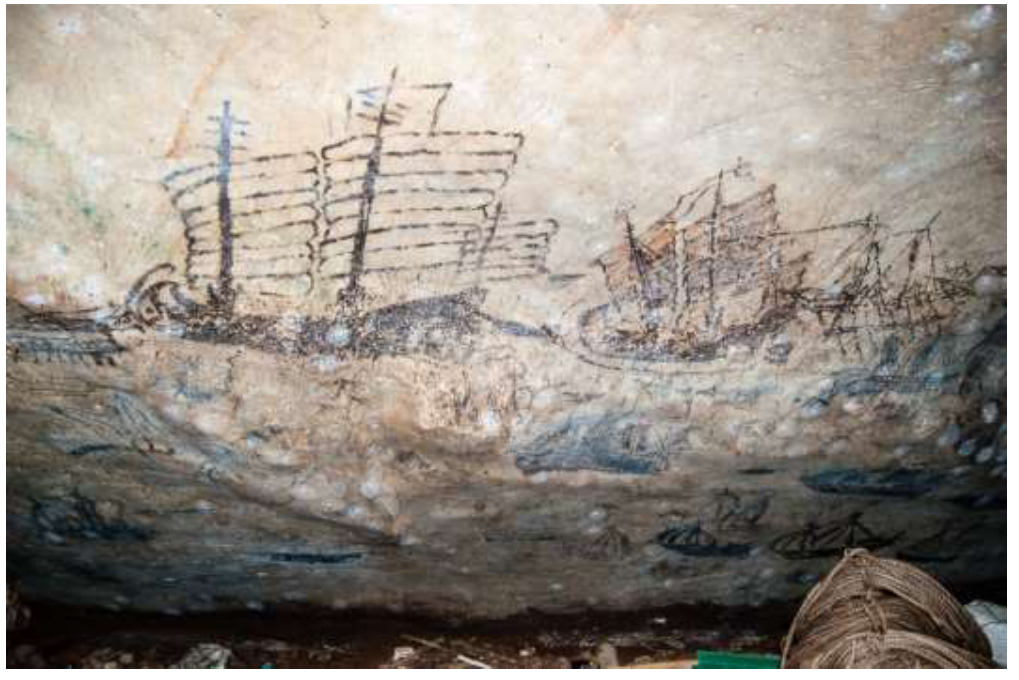
Figure 2. Tham Phrayanak in Krabi province contains many depictions of ships from several cultures. Photo: Noel H.